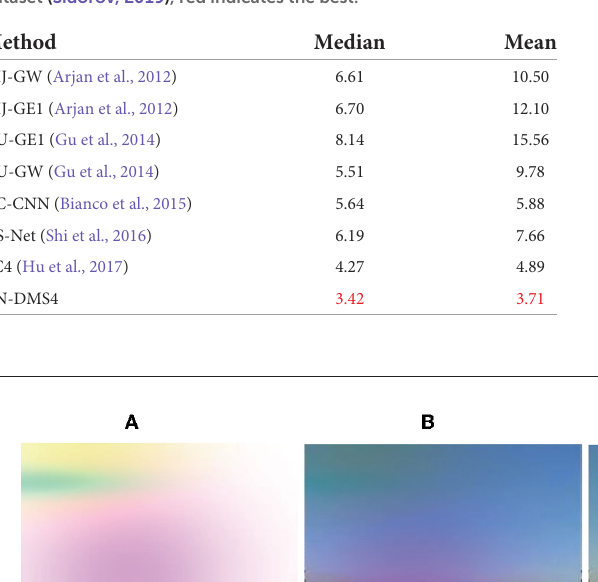
TABLE 4 Quantitative evaluation on the tinted multi-illuminant dataset (Sidorov, 2019), red indicates the best.